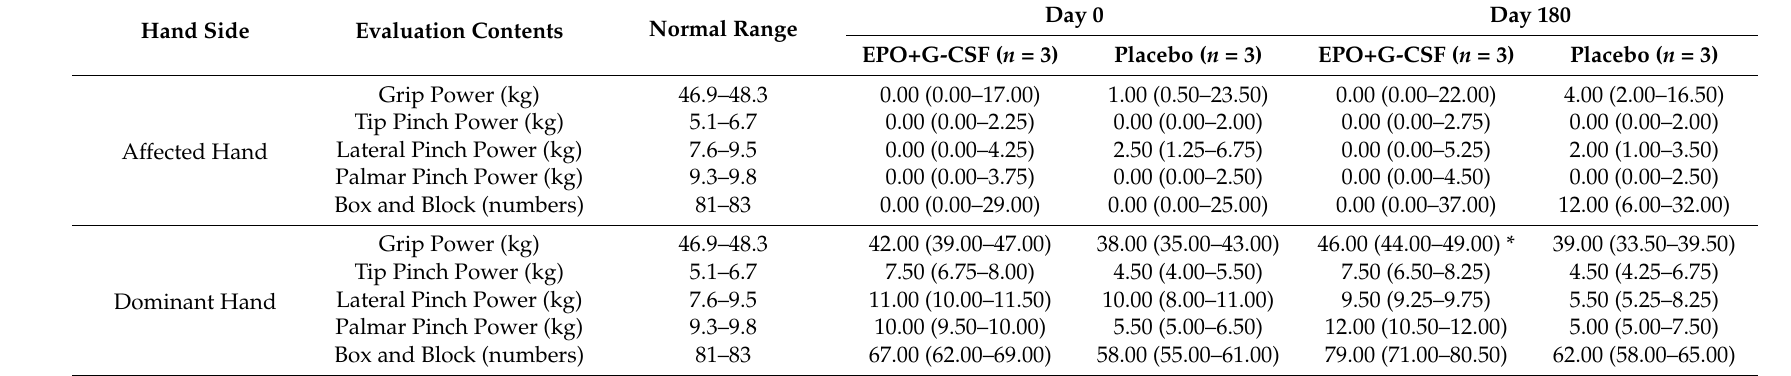
Table 5. Hand function outcomes of the EPO and G-CSF combination therapy in an exploratory double-blind